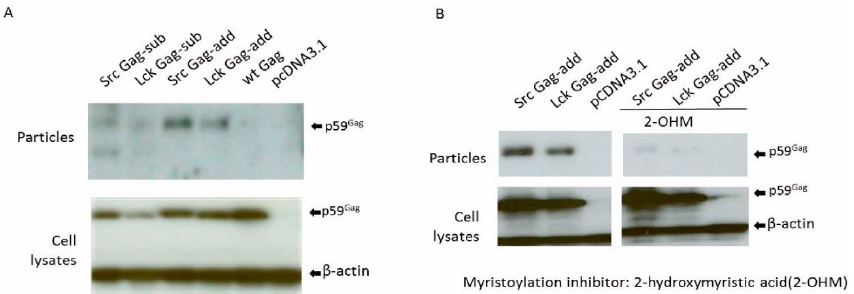
Figure 4. BFV myr ‐ Gag release as subviral particles without Env depends on Gag myristoylation. Proteins of cell lysates and virus particle preparations were harvested two days post ‐ transfection. Equal protein aliquots of cell lysates and SVPs in supernatants were separated by SDS ‐ PAGE and assayed for BFV Gag by immunoblotting. The position of the precursor form of BFV Gag (p59) is marked. Proper protein loading was determined by probing for β‐ actin. ( A ) The influence of myr ‐ signals on Env ‐ independent BFV Gag SVP release was determined by transfecting HEK293T with the BFV myr ‐ sub or ‐ add Gag expression clones pBC ‐ SrcGag ‐ sub, pBC ‐ LckGag ‐ sub, pBC ‐ SrcGag ‐ add, and pBC ‐ LckGag ‐ add. HEK293T were also transfected with the unmodified parental BFV Gag expression constructs pBC ‐ wtGag. The empty vector pCDNA3.1 was used as a